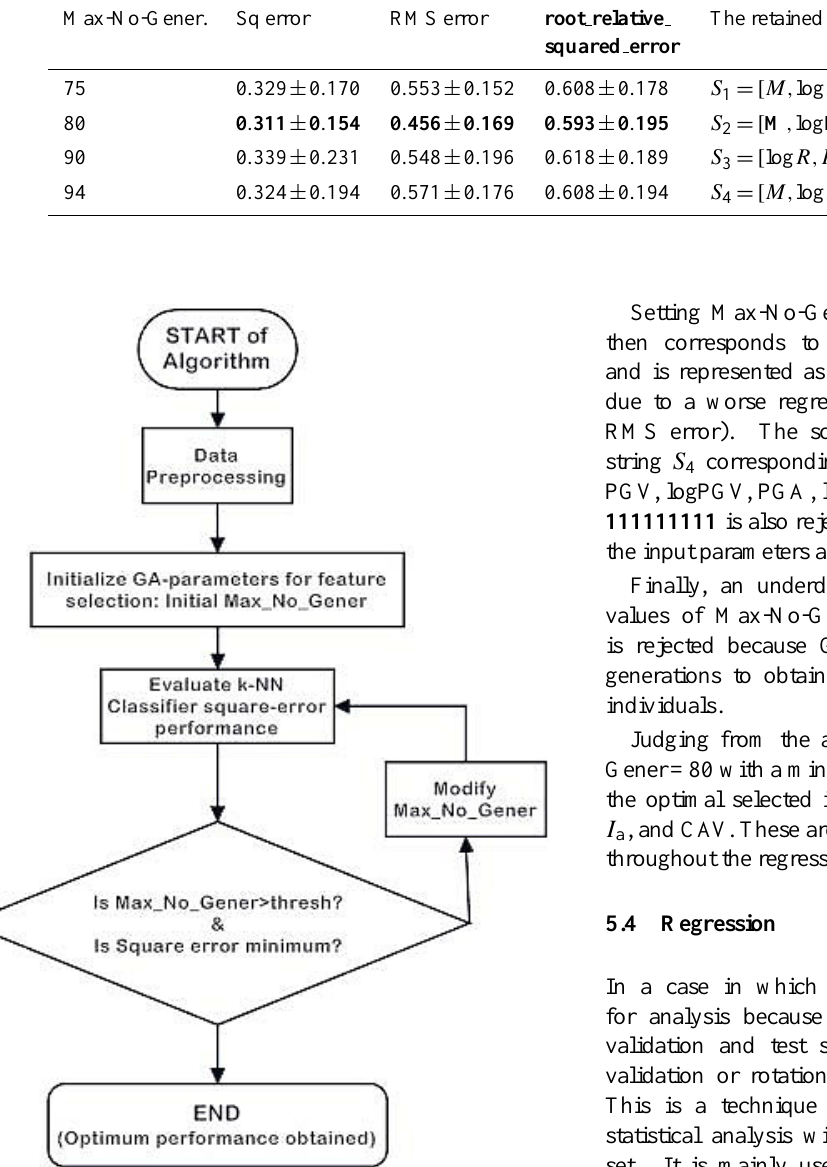
Table 2. The parameters retained by the GA-ANN selection algorithm and corresponding regression performance (columns 2 and 3). Max-No-Gener.